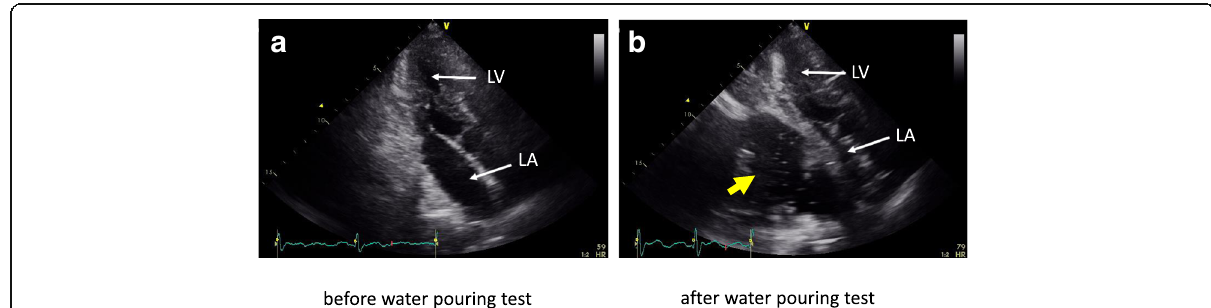
Fig. 3 Transthoracic echocardiography. a Echocardiography before the water pouring test. b Echocardiography showed that after instillation of 2000 ml of saline, the left atrium was markedly compressed and the area of the mitral annulus was reduced. The yellow arrow indicates saline in the